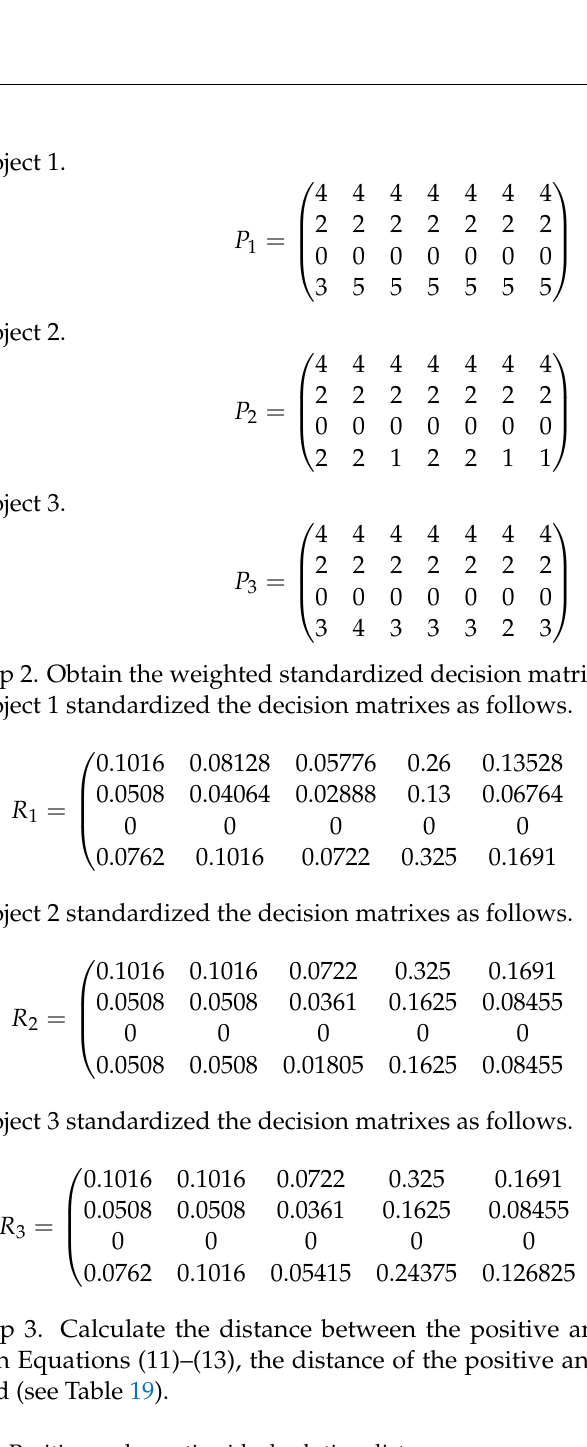
Table 19. Positive and negative ideal solution distance. Positive and Negative Ideal Solution